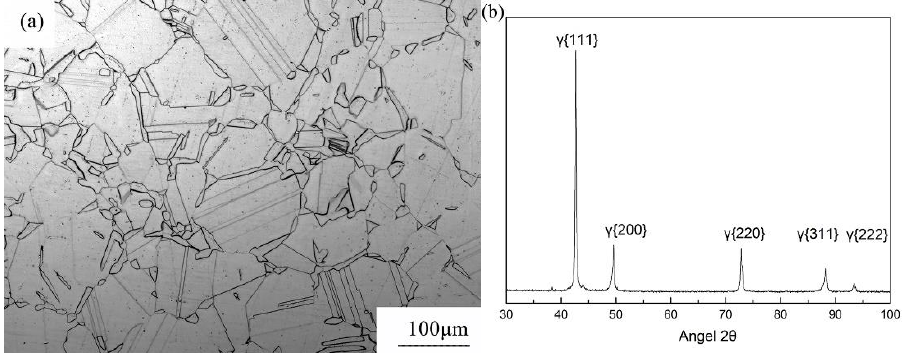
Figure 1. ( a ) Initial OM microphotograph of the steel; ( b ) XRD spectra of steel.